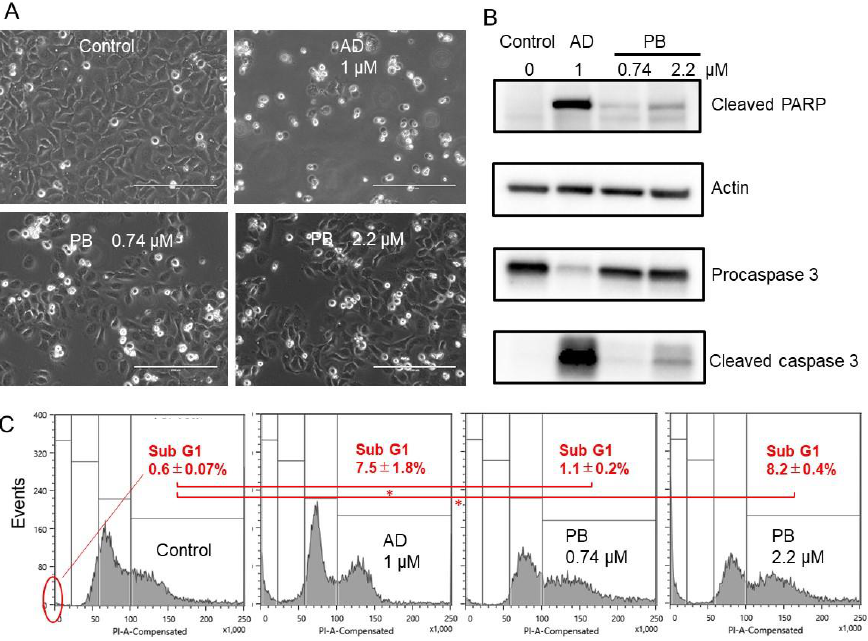
Figure 3. Pyoktanin (PB) induces apoptosis in Ca9-22 cells. Ca9-22 cells were incubated for 24 h and